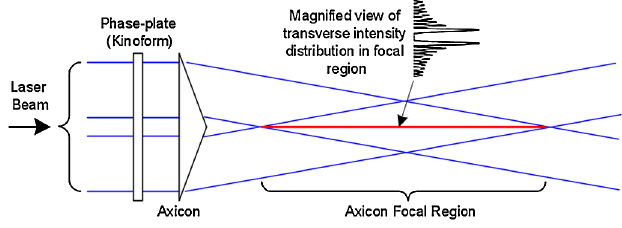
FIG. 1. Schematic of focusing a laser beam with an axicon and phase